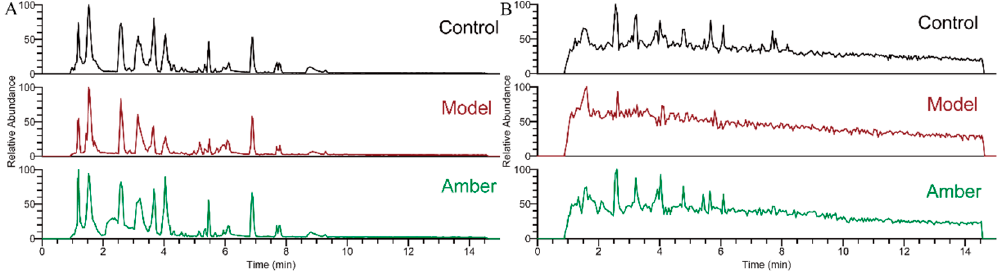
Figure 3. Base peak chromatograms (BPCs) of cortex samples of control group, model group, and amber group under ESI + ( A ) and ESI − ( B ) MS conditions.